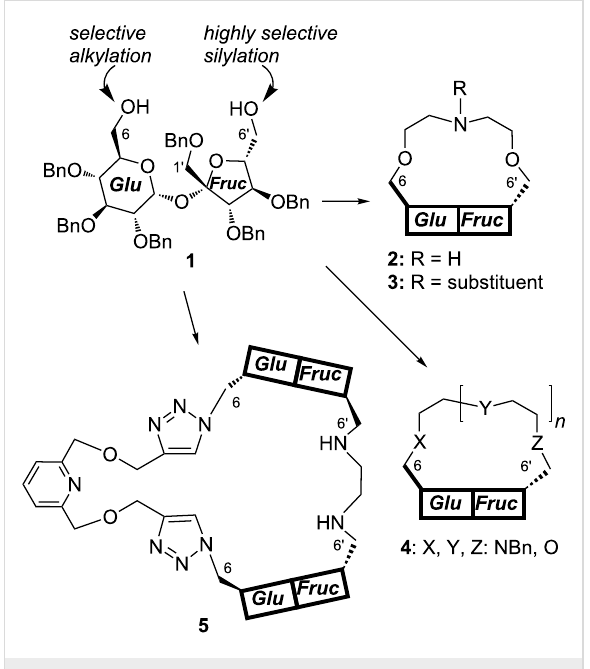
Figure 1: Examples of sucrose-based macrocycles.